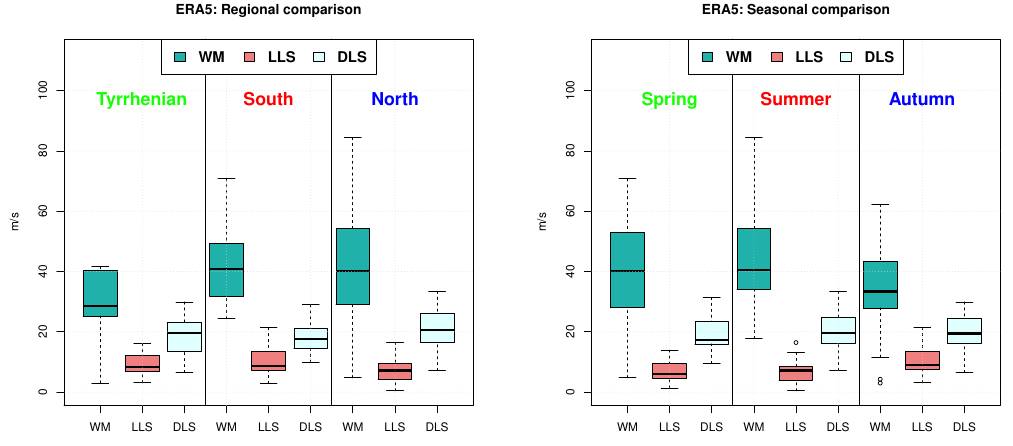
Figure 3. Boxplots of WM, LLS and DLS values in different sub-regions ( left ) and seasons ( right ) considering the ERA-5 dataset. The edges of the box indicate the 25th and 75th percentiles. The whiskers correspond to approximately 99% confidence interval.